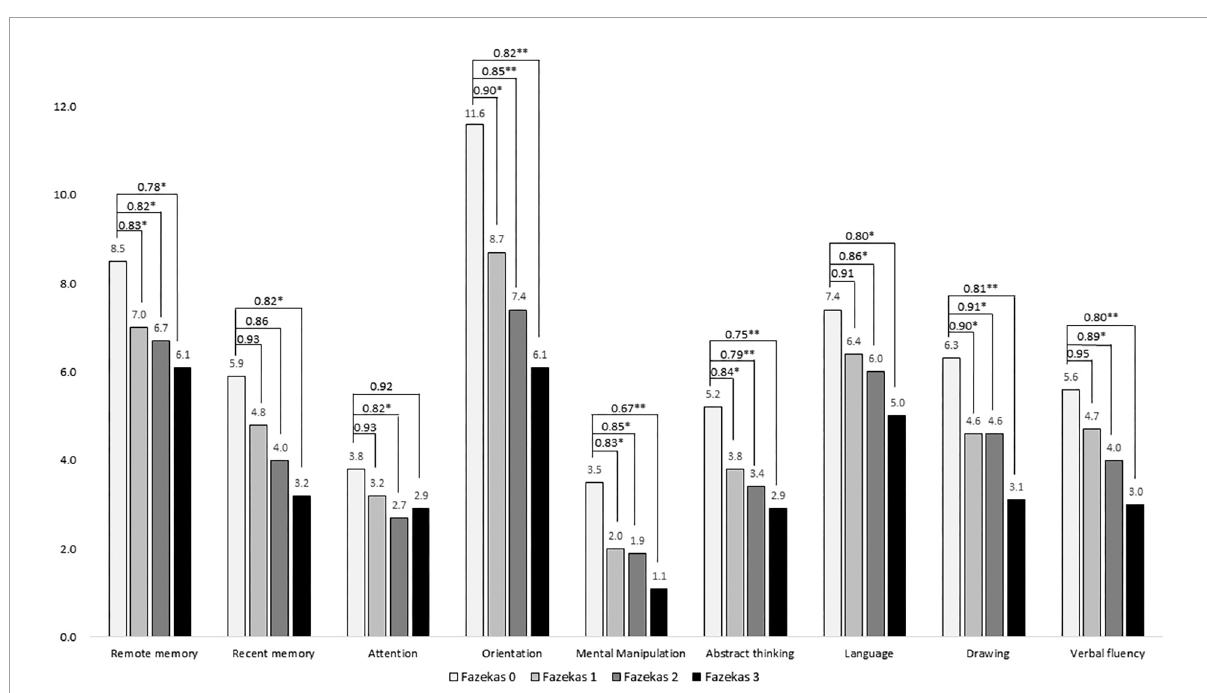
FIGURE2 Comparison of cognitive domains of the CASI among different Fazekas groups adjusted for age, sex, education, and disease duration. ORs were compared to Fazekas score of 0. ∗ p < 0.05; ∗∗ p < 0.001.